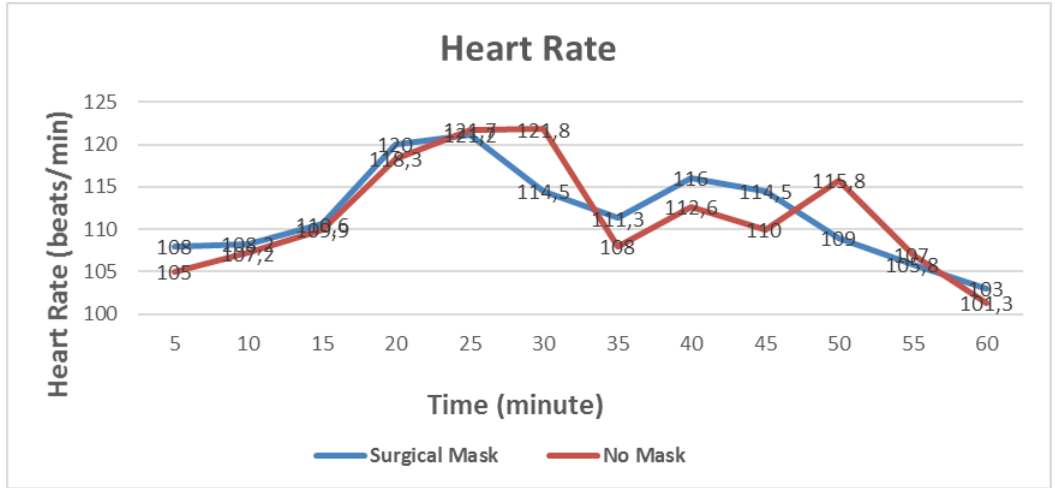
Figure 2. Mean changes in the HR (rate/min) values during the one-hour walking exercise performed by 30 subjects with and without a surgical face